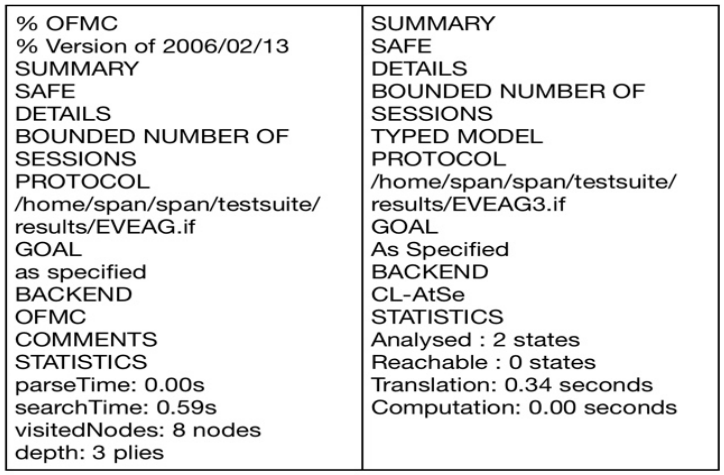
Figure 12. Mutual Authentication: AVISPA simulation results.